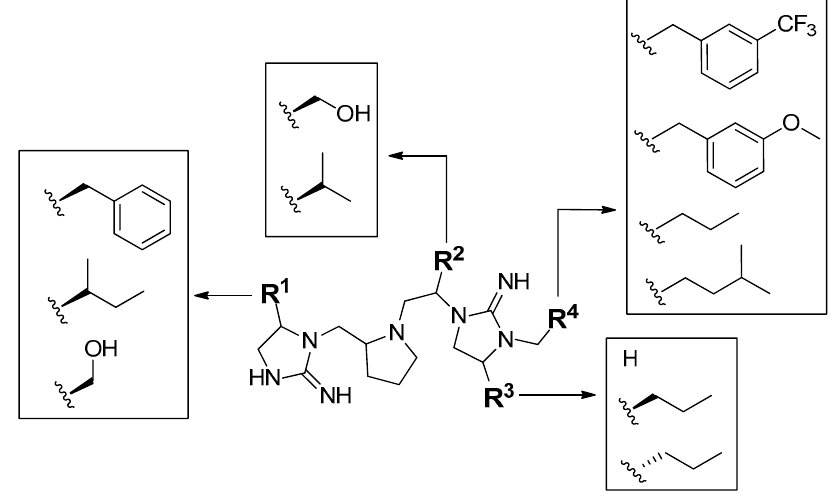
Figure 3. Identification of active groups at positions R 1 –R 4 in the compound mixture.